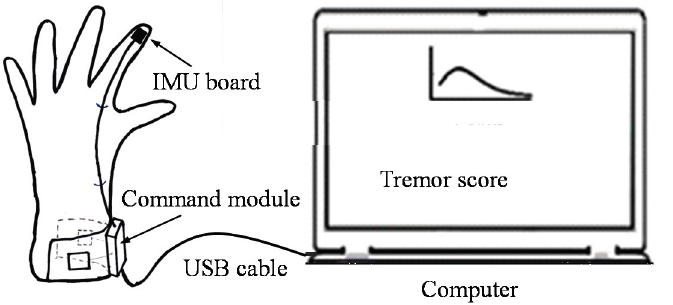
Figure 2. System diagram of the tremor assessment system. This system consists of two parts: glove part ( left ) and computer part ( right